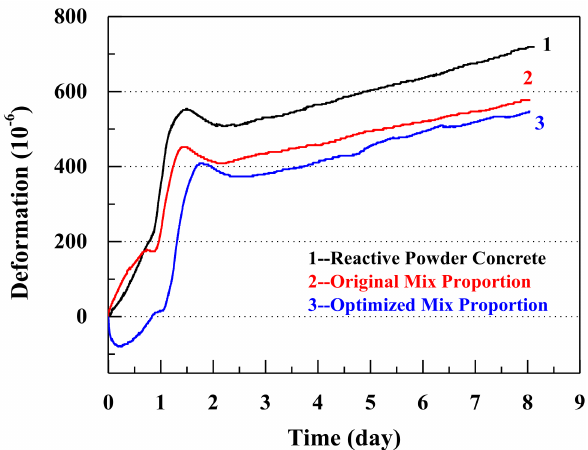
Figure 13. The autogenous shrinkage properties of the three different concretes.